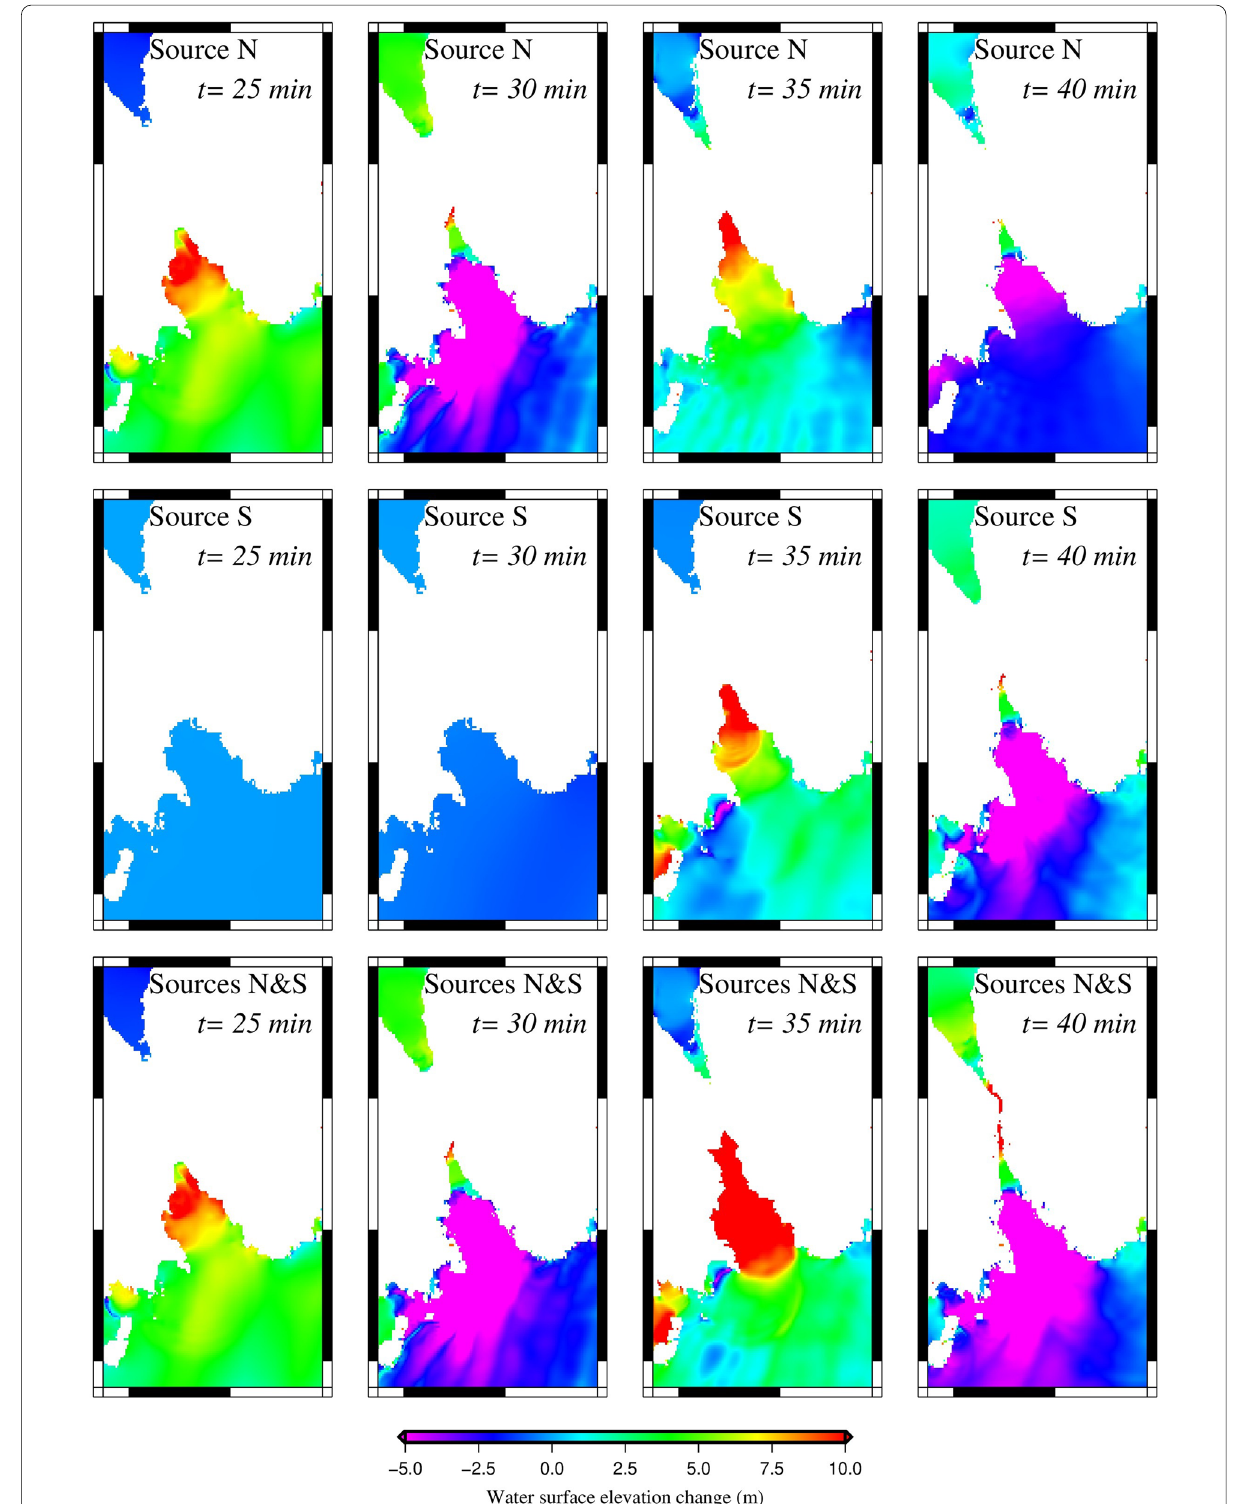
Fig. 7 Snapshots of tsunami propagation and inundation around the valley of Koyadori. The upper, middle, and bottom panels provide the results for the scenarios with sources N, S, and N and S,